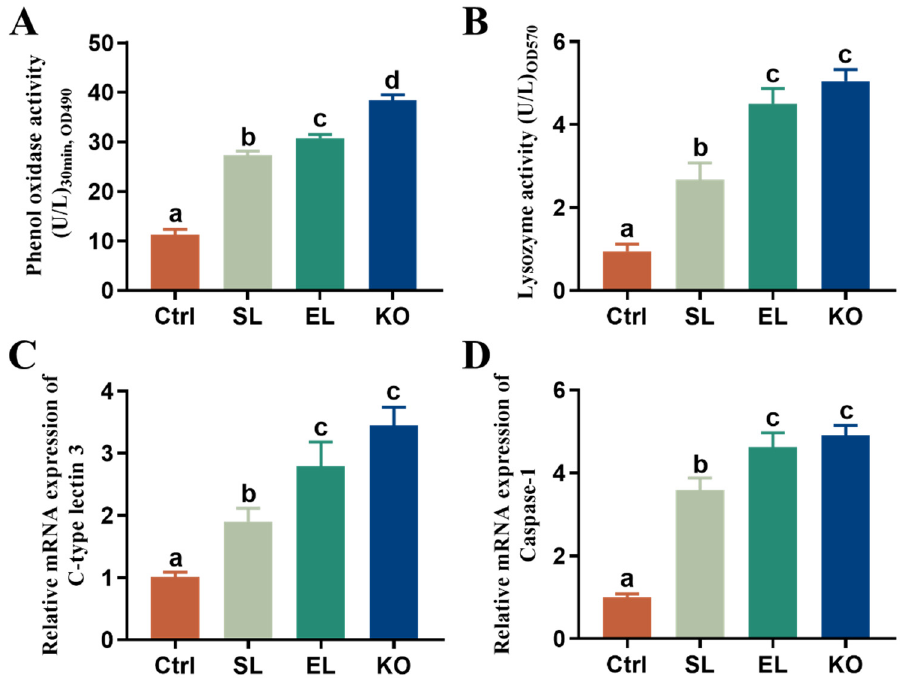
Figure 3. Immune response of female L. vannamei fed different experimental diets. ( A ) Phenol oxidase activity in serum. ( B ) Lysozyme activity in serum. ( C ) Relative mRNA expression of C-type lectin 3 in hepatopancreas. ( D ) Relative mRNA expression of Caspase-1 in hepatopancreas. The values are the mean ± standard errors ( n = 4). Values with superscript different letters indicate significant differences ( p < 0.05) among all the treatments.